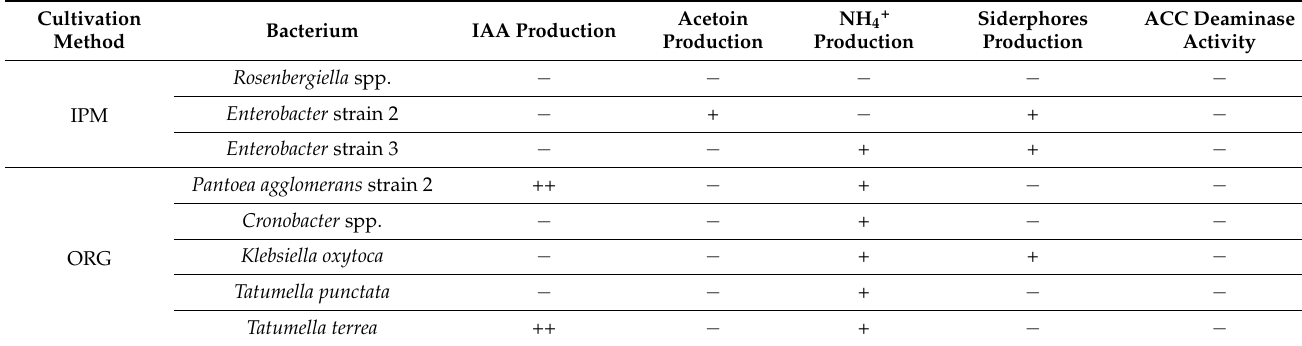
Table 2. Functional traits of bacteria strains isolated uniquely in organic or IPM berries. Cultivation Method